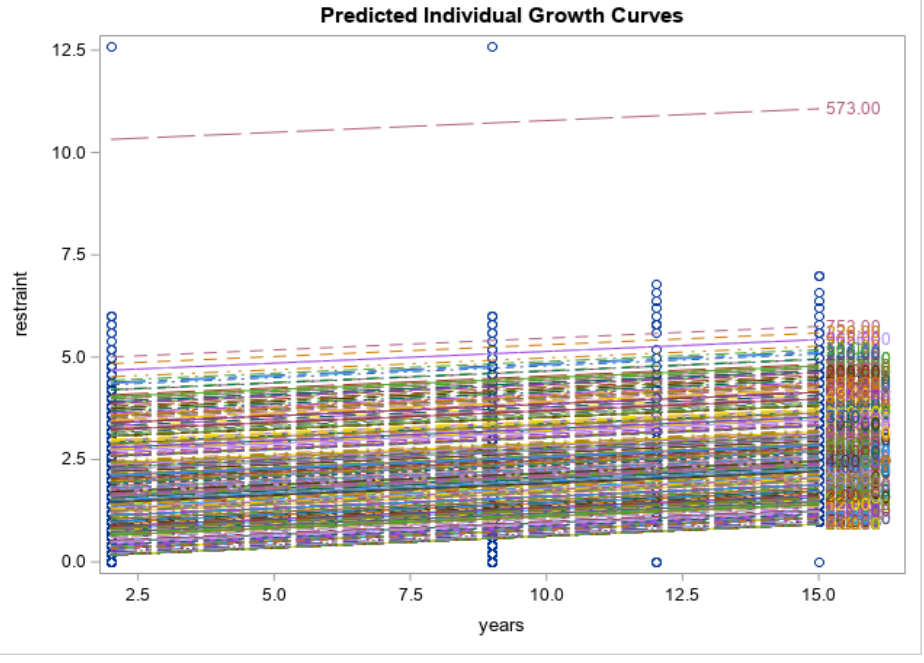
Figure 4. Predicted individual growth curves for eating restraint. The blue lines indicate the measurement time points.